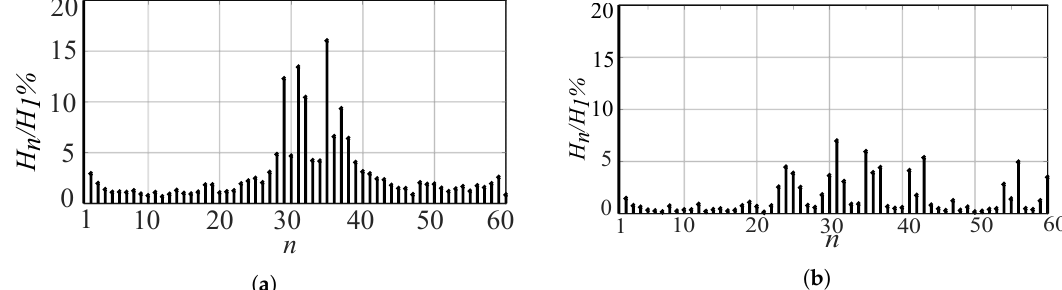
Figure 3. FFT of the output phase voltage: ( a ) TLI. ( b ) 5-level inverter.